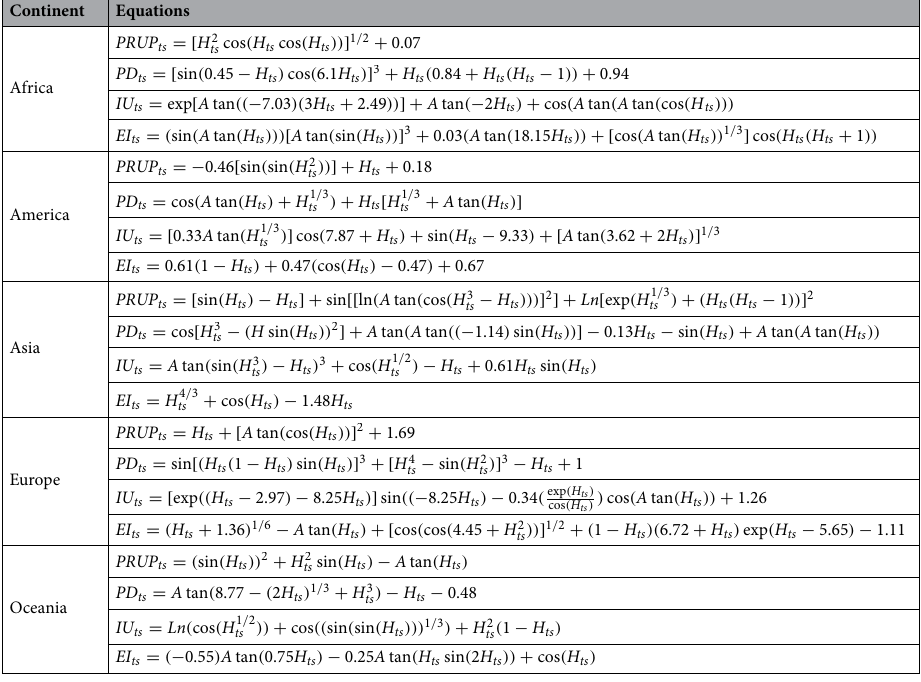
Table 6. Mathematical equations governing hydro-social indicators. H denotes Hydro: renewable water per